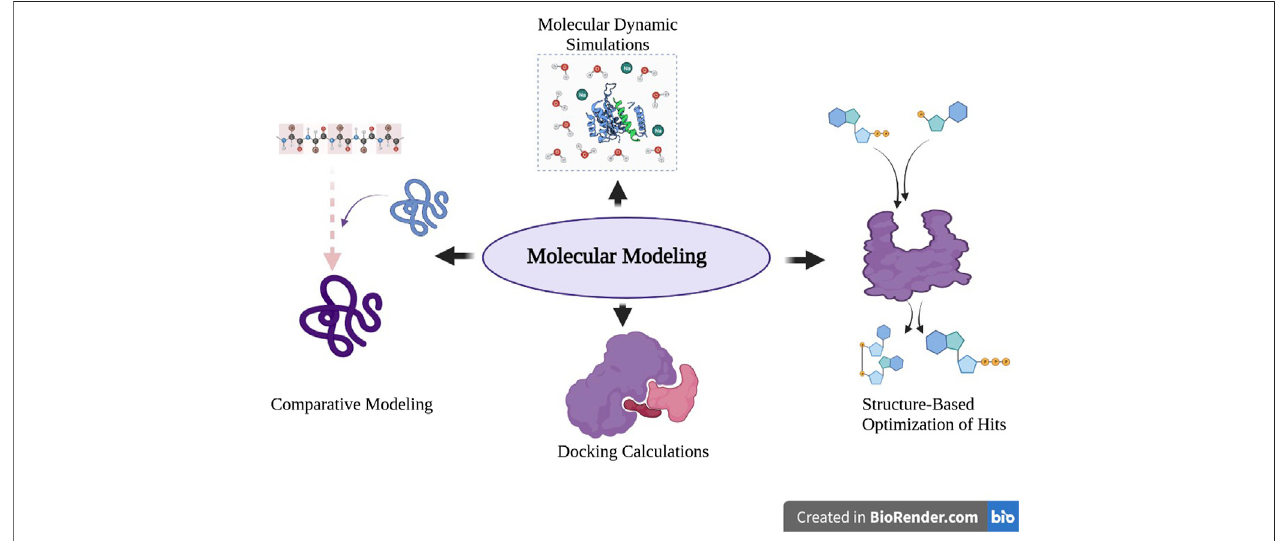
FIGURE 2 | Common computational approaches applied to study the effect of mutations on protein – ligand